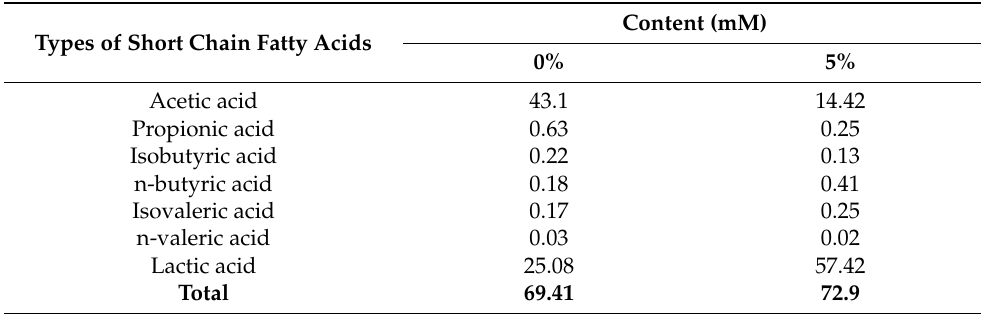
Table 1. Type and content of SCFA after fermentation of L. acidophilus with addition of XOS (5%) as carbon source compared to medium containing glucose